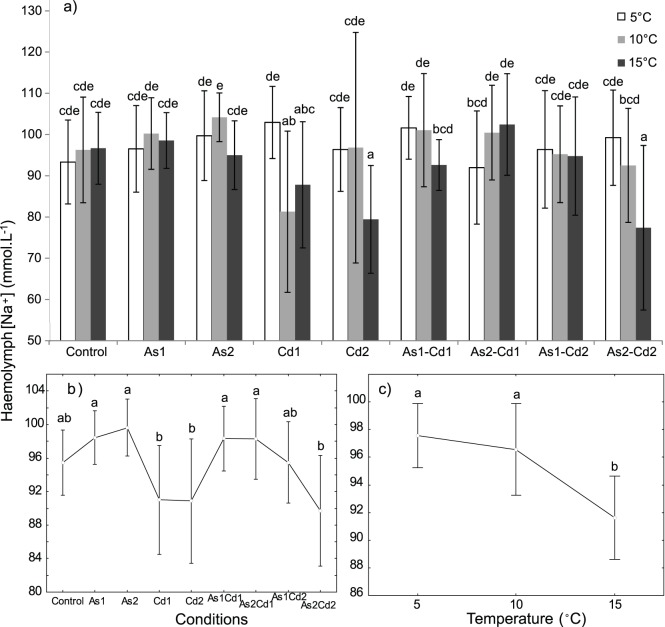
Mean concentrations of haemolymphatic [Na+](mmol L−1) in Gammarus pulex.
 Concentrations obtained for individuals exposed 96 h to different conditions (control, arsenate, cadmium and four binary mixtures) at three temperatures (5-10-15°C). a)
Temperature × condition effect: Mean haemolymphatic [Na+] for each tested condition and temperature. Vertical bars represent standard deviations. b)
Condition effect: Weighted mean haemolymphatic [Na+]for each tested condition (results for all the tested temperatures were combined). Vertical bars represent 0.95 confidence intervals. c)
Temperature effect: Weighted mean haemolymphatic [Na+] for each temperature (results for all the tested conditions were combined). Vertical bars represent 0.95 confidence intervals. Letters (a to e) were used as labels to illustrate significant differences in values of mean haemolymphatic [Na+] (two-way ANOVAs + LSD Fisher post hoc tests; at p<0.05 level of significance).